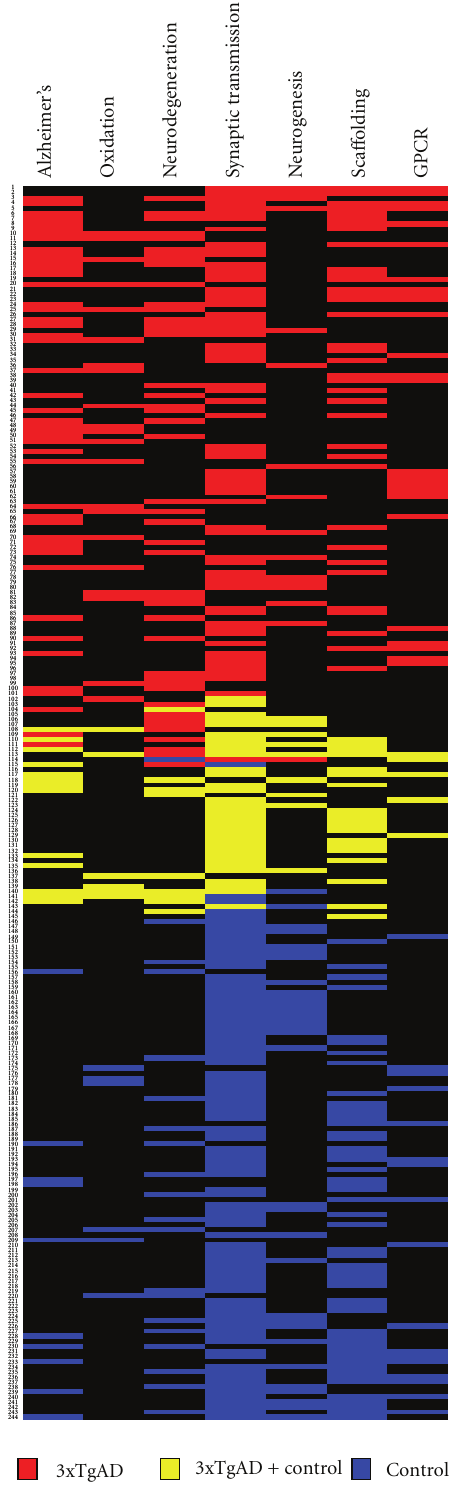
Figure 6: Multidimensional protein latent semantic indexing (LSI) analysis of proteins extracted from control and 3xTgAD lipid rafts. Proteins from the control or 3xTgAD extracted datasets that possessed an explicit latent semantic indexing (LSI, GeneIndexer, Computable Genomix) score in at least two of the multiple GeneIndexer interrogation terms (Alzheimer’s, oxidation, neurodegeneration, synaptic transmission, neurogenesis, sca ff olding, and GPCR) are represented in a heatmap format. Proteins are identified on the left side of the heatmap as an individual number (see Appendix H for key). The presence of a colored panel (3xTgAD, red: control, blue: 3xTgAD and control: yellow) on the same lateral as the numbered protein denotes explicit textual correlation of that protein with the specific vertical interrogation